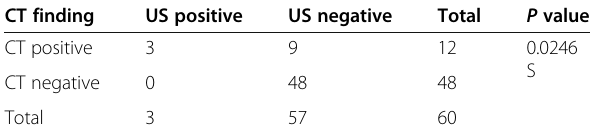
Table 3 Computed tomography findings CT finding